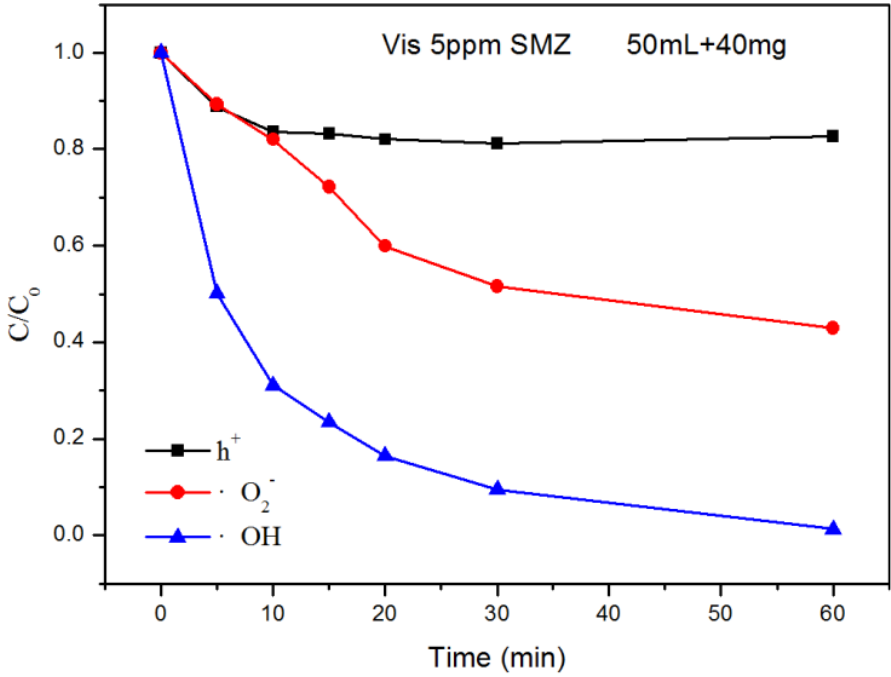
Figure 9. Trapping experiments of by Core shell @C 3 N 4 /ZnO catalyst with/without scavengers in the degradation of SMZ.